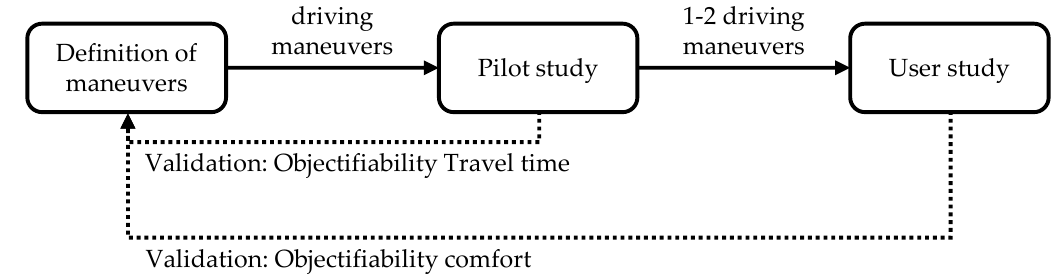
Figure 4. Methodology for the two-dimensional objectification of driving comfort and travel time.